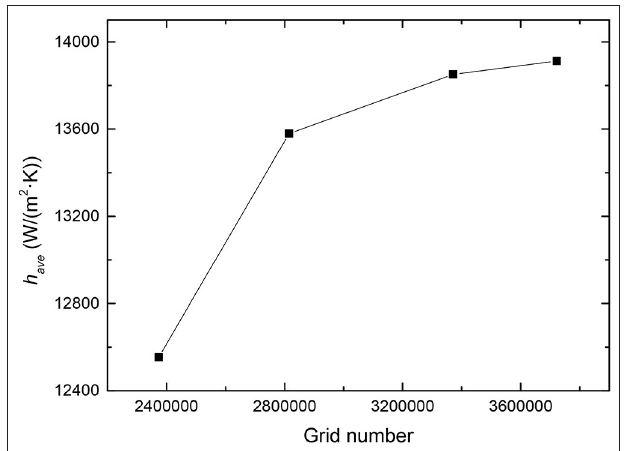
FIGURE 6 | The results of grid independent validation test.